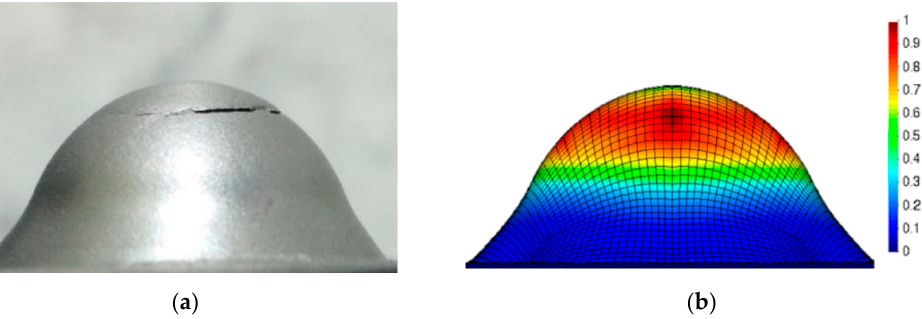
Figure 7. Erichsen test of the EK4 steel: ( a ) Fracture stage of the sample showing a crack near its cup and ( b ) numerical damage index contours exhibiting a maximum value in the same cracked zone of the sample.